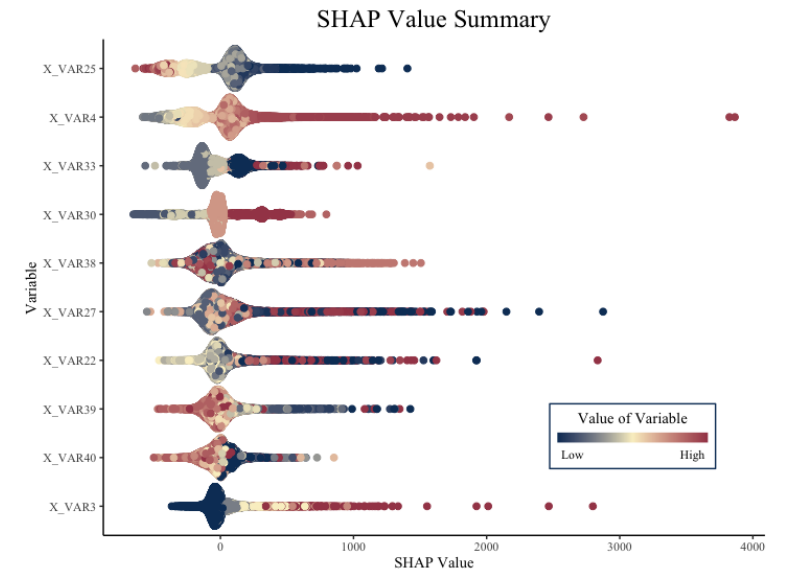
Figure 6. Summary plot of the two-part model’s mSHAP values.